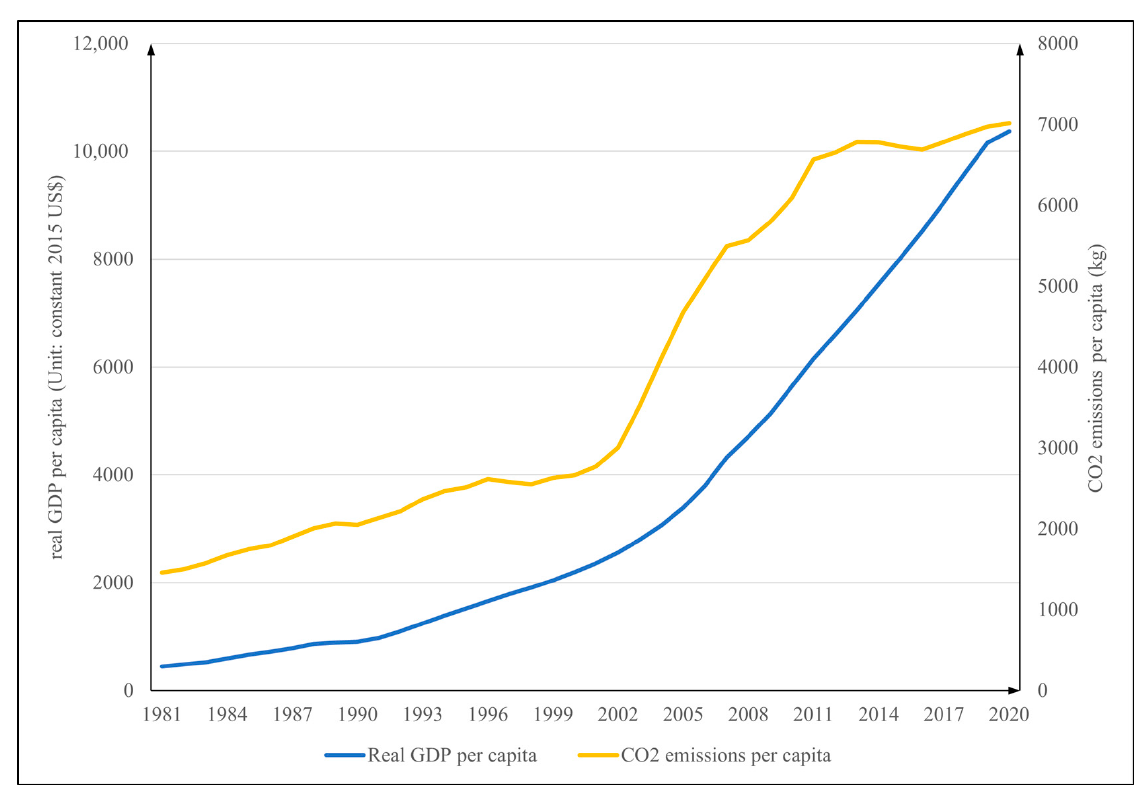
Figure 3. Trend of per capita GDP and CO 2 emissions from 1981 to 2020 in China.